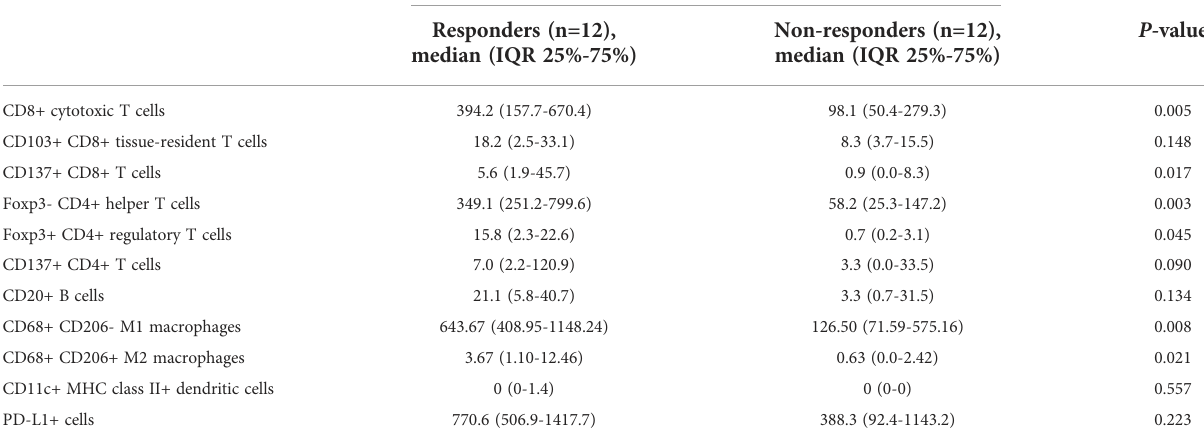
TABLE 2 Immune cell in fi ltration densities between the treatment responders and